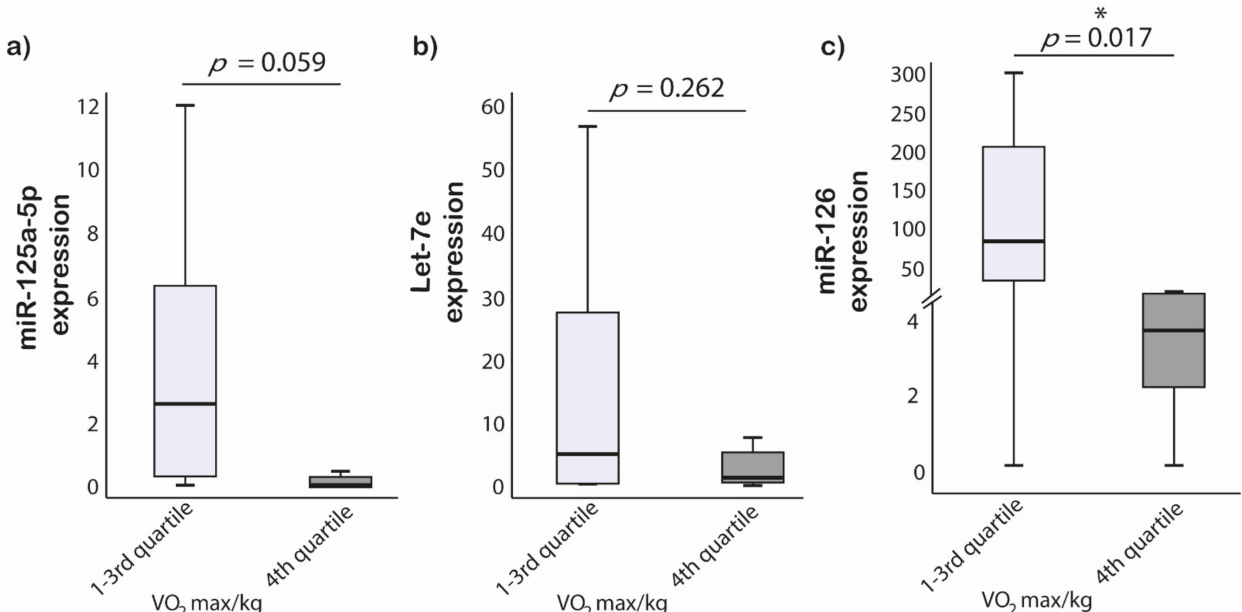
Figure 4. MiRNAs expression difference between fourth quartile and lower quartiles of VO 2 max/kg in ultra-marathon runners. ( a ) miR-125a-5p; ( b ) Let-7e; ( c ) miR-126, * Comparison is significant at the 0.05